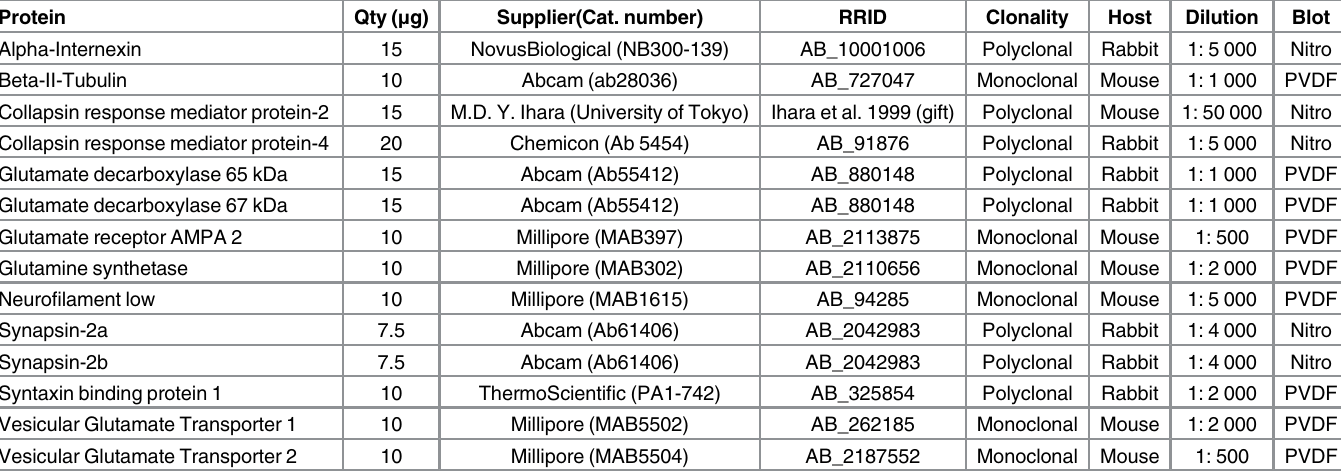
Table 1. List of antibodies for western blot